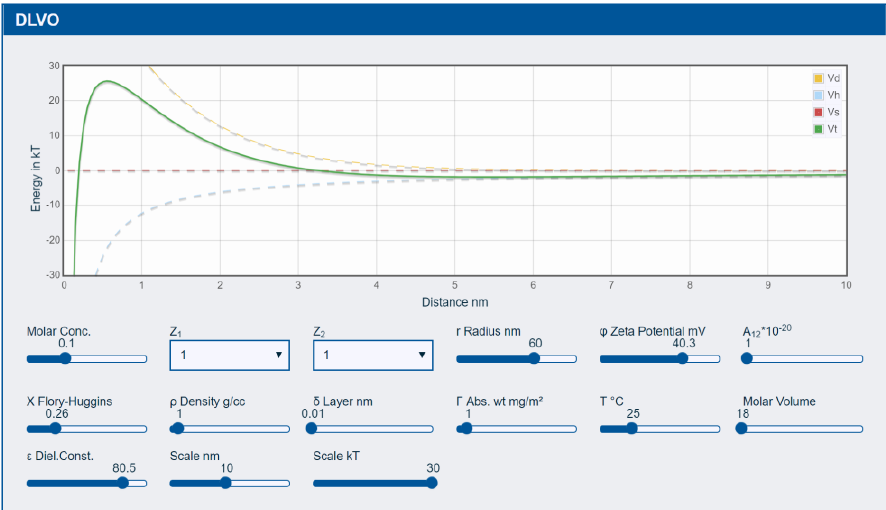
Figure 1. A stable DLVO setup. The formulation is in water (ε = 80), there is a reasonable zeta potential of 40 mV, and the salt concentration of monoionic species is not too high. The V h (Hamaker) attraction eventually overwhelms the V d (Debye) charge repulsion, but there is a satisfactory 25 kT barrier at ≈ 0.5 nm. The app is at www.stevenabbott.co.uk/practical-solubility/dlvo.php.